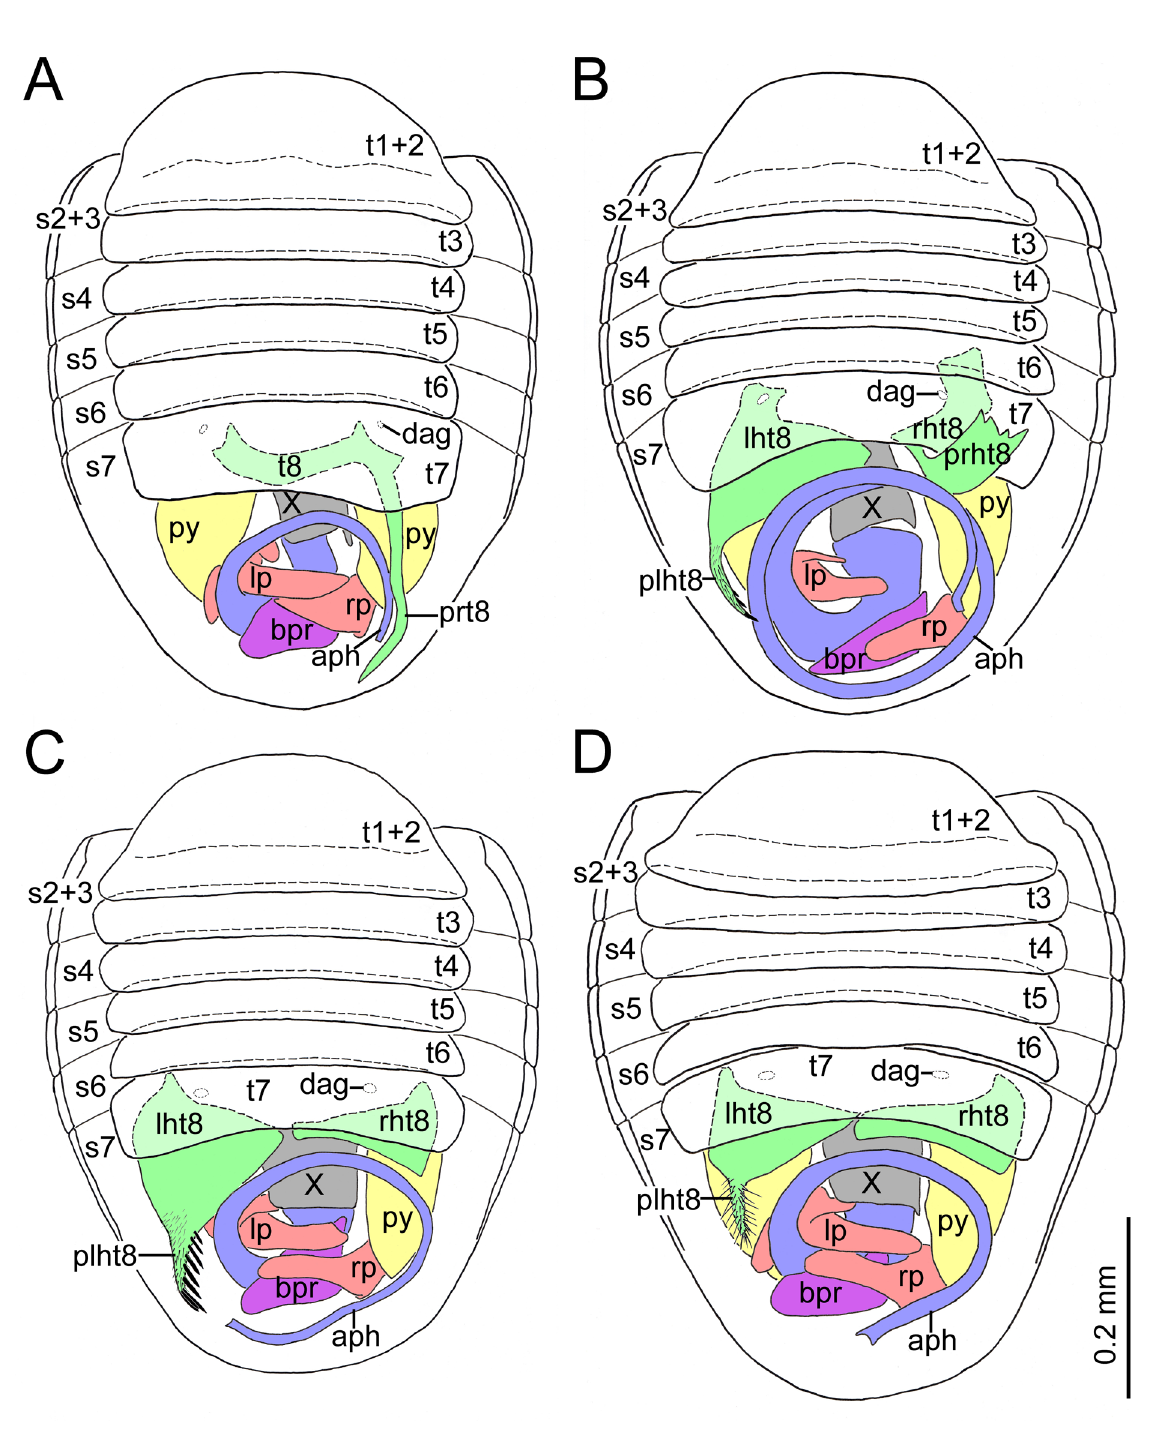
Fig. 28. Pregenital abdomen and genitalia of Kokeshia spp., dorsal views. A . K. acutiformis sp. nov., paratype, ♂ (SYSBM). B . K. baii sp. nov., paratype, ♂ (SYSBM). C . K. bui sp. nov., paratype, ♂ (SYSBM). D . K. caii sp. nov., paratype, ♂ (SYSBM). Abbreviations: see Material and